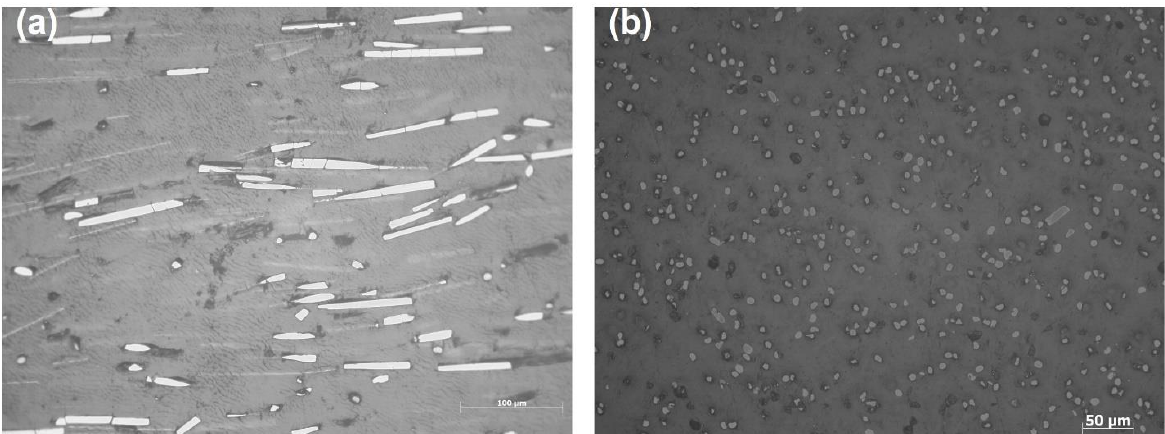
Figure 8. The microscope images of short carbon fibres in SFRN filaments: ( a ) longitudinal; ( b ) axial.